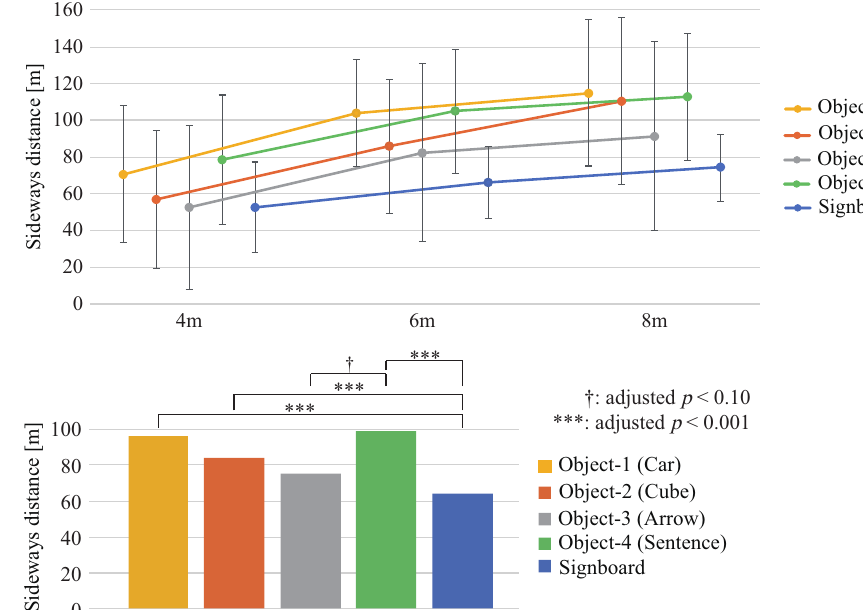
Figure 6. The results at 4 m, 6 m, and 8 m points.